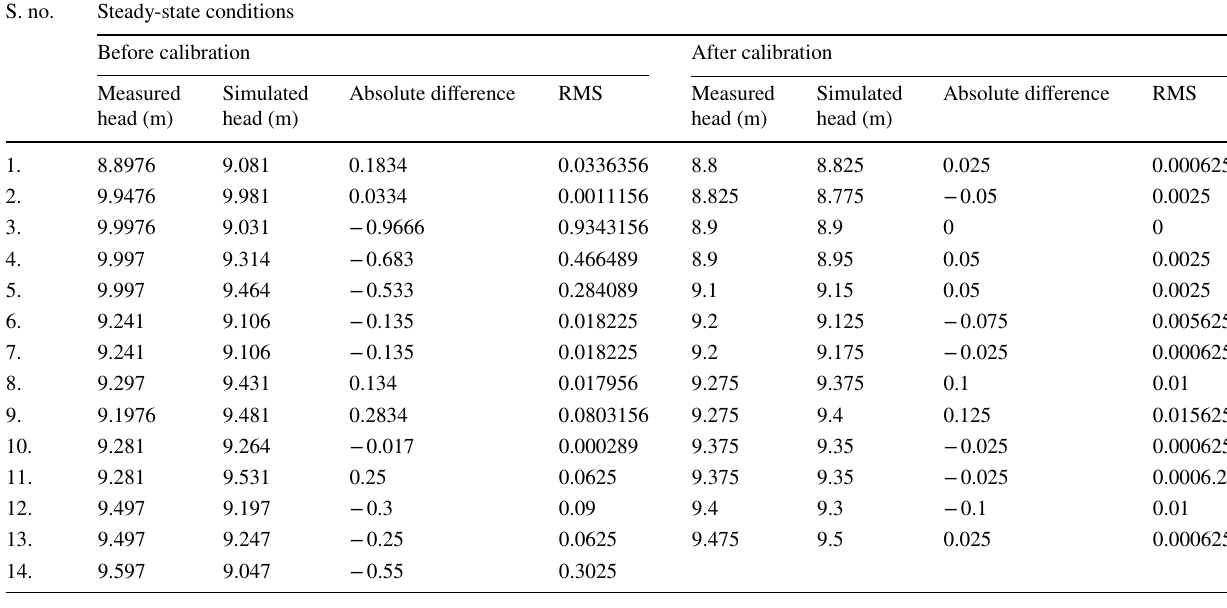
Table 10 Measured and simulated head in 14 observation wells of Quaternary aquifer (steady state) S. no.